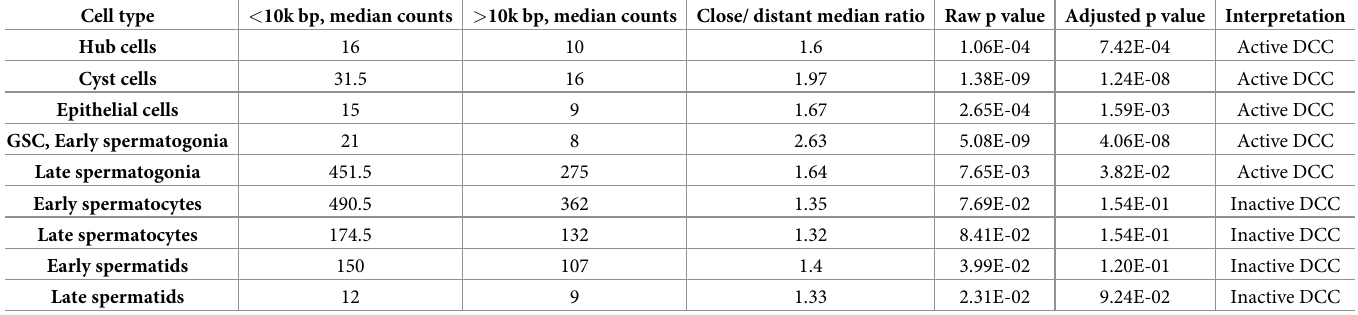
Table 2. Evidence of DCC activity in somatic cells and pre-meiotic germ cells. In each cell type we have calculated the median counts for X chromosome genes within 10000 bp of an annotated CES and genes outside 10000 bp, corresponding to Fig 4. In hub, cyst, epithelial, GSC, early and late spermatogonial cells, a two-tailed Wilcoxon test finds that these two sets of genes have statistically different count distributions with an alpha of 0.05. These cell types have a higher ratio of median counts from close and distant genes, indicating that CES sites influence X chromosome gene expression in these cell types, a hallmark of dosage compensation. The cell type with the highest difference between close/distant x gene expression is GSC/early spermatogonia, which also had the highest X/autosome ratio in Table 1. DCC means dosage compensation complex. Cell